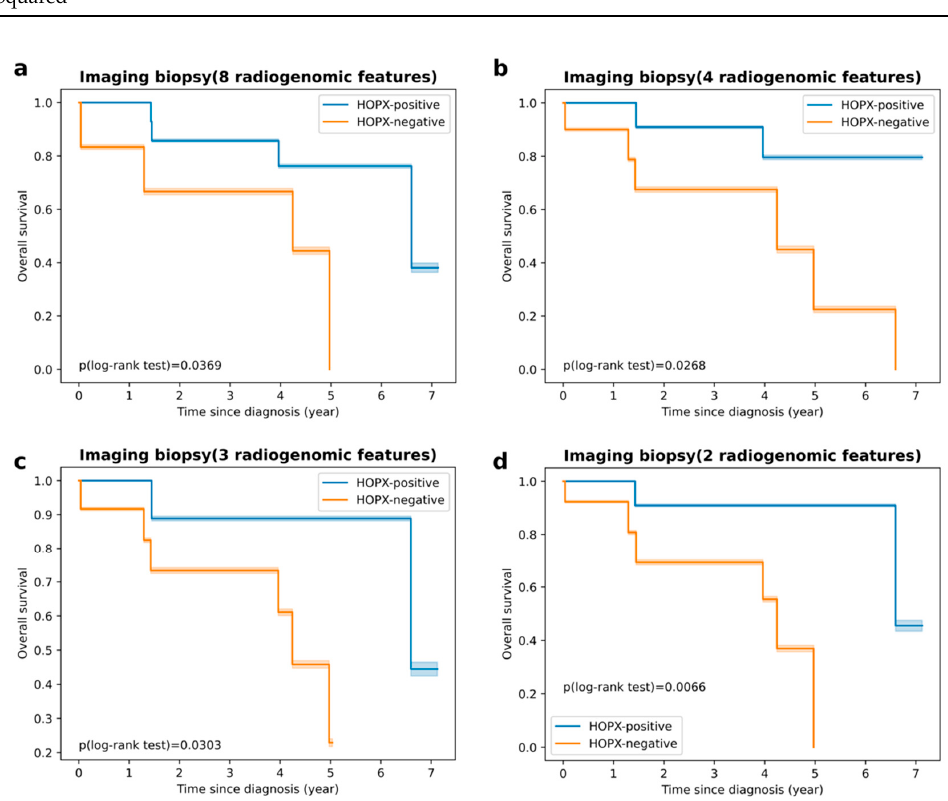
Figure 5. Kaplan–Meier curves of survival in test dataset: ( a ) survival curves of imaging biopsy consisting of 8 radiogenomic features ( p = 0.0369, log-rank test); ( b ) survival curves of imaging biopsy consisting of 4 radiogenomic features ( p = 0.0268, log-rank test); ( c ) survival curves of imaging biopsy consisting of 3 radiogenomic features ( p = 0.0303, log-rank test); ( d ) survival curves of imaging biopsy consisting of 2 radiogenomic features ( p = 0.0066, log-rank